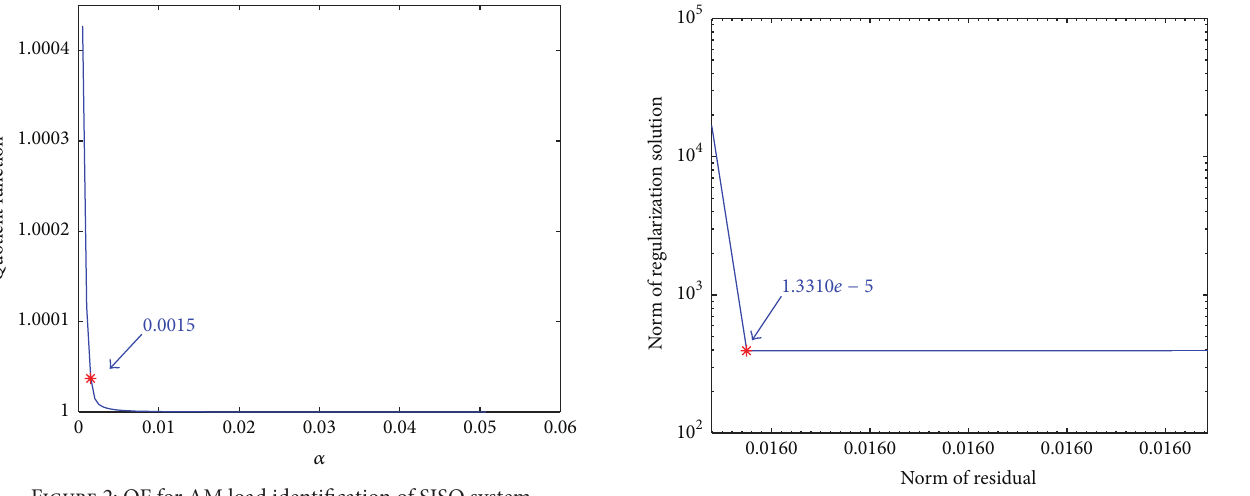
Figure 4: L -curve for AM load identification of SISO system.